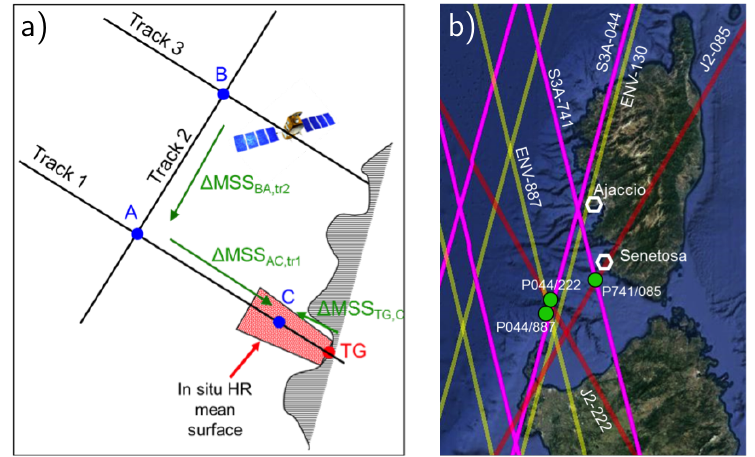
Figure 26. ( a ) Generic diagram of the regional calibration method (image taken from [42]). ( b ) Configuration in Corsica for the Sentinel-3A mission. S3A ground tracks in pink, Jason-2 tracks in red and Envisat tracks in yellow. The green dots show the crossover points where the offshore S3A SSH bias was computed in